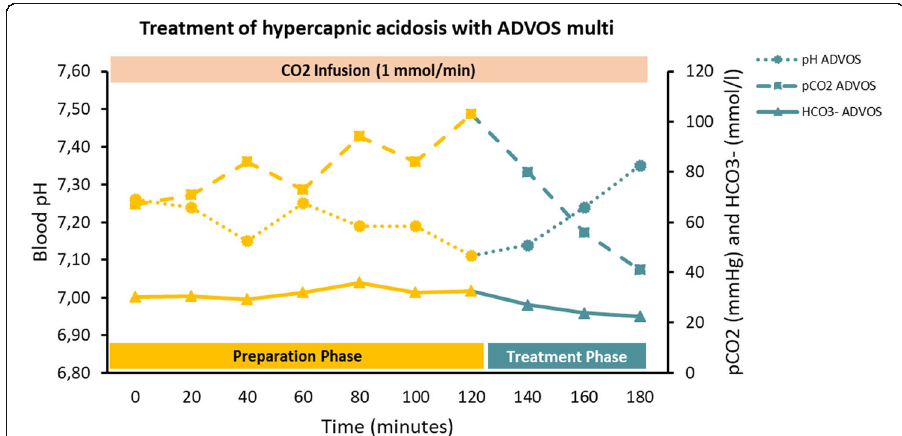
Fig. 6 Course of pH, pCO 2 , and HCO 3 − in blood during ADVOS multi treatment with a continuous supply of 27 ml/min of CO 2 . During the preparation phase (yellow), a respiratory acidosis was triggered while this was corrected during the treatment phase